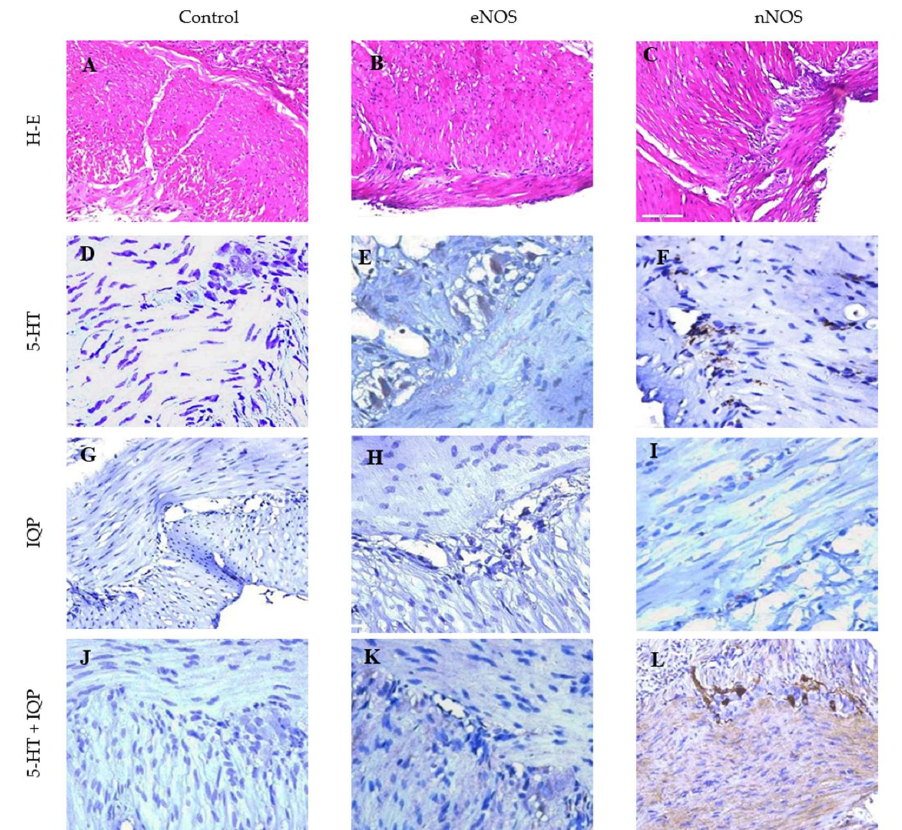
Figure 4. Histologic and immunohistochemical results from SM of the stomach and myenteric plexus. ( A ) preparation incubated with 5-HT, H-E staining, × 20; ( B ) incubated with IQP, H-E staining, ×20; ( С ) incubated with 5-НТ + IQP, Н-Е staining, ×20; ( D ) incubated with 5-НТ, control, ×20; ( Е ) incubated with 5-НТ, presence of slight eNOS expression of in myenteric plexus, ×20; ( F ) incubated with 5-HT, presence of slight nNOS expression of in myenteric plexus and neuronal branches between SM cells, × 20; ( G ) incubated with IQP, control, × 20; ( H ) incubated with IQP, lack of eNOS expression, × 20; ( I ) incubated with IQP, single cells are positive for nNOS in myenteric plexus and SM cells, × 20; ( J ) incubated with 5-HT + IQP, control, × 20; ( K ) incubated with 5-HT + IQP, presence of slight eNOS expression in myenteric plexus and SM cells, × 20; and ( L ) incubated with 5-HT + IQP, increased intensity and density in the nNOS manifestation in myenteric plexus and SM cells, × 20.